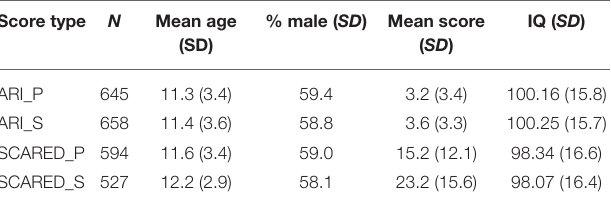
TABLE 1 | Demographic repartition of each of the subgroups from separate analyses; mean scores of questionnaires and standard deviation; ARI, Affective Reactivity Index; SCARED, Child Anxiety Related Emotional